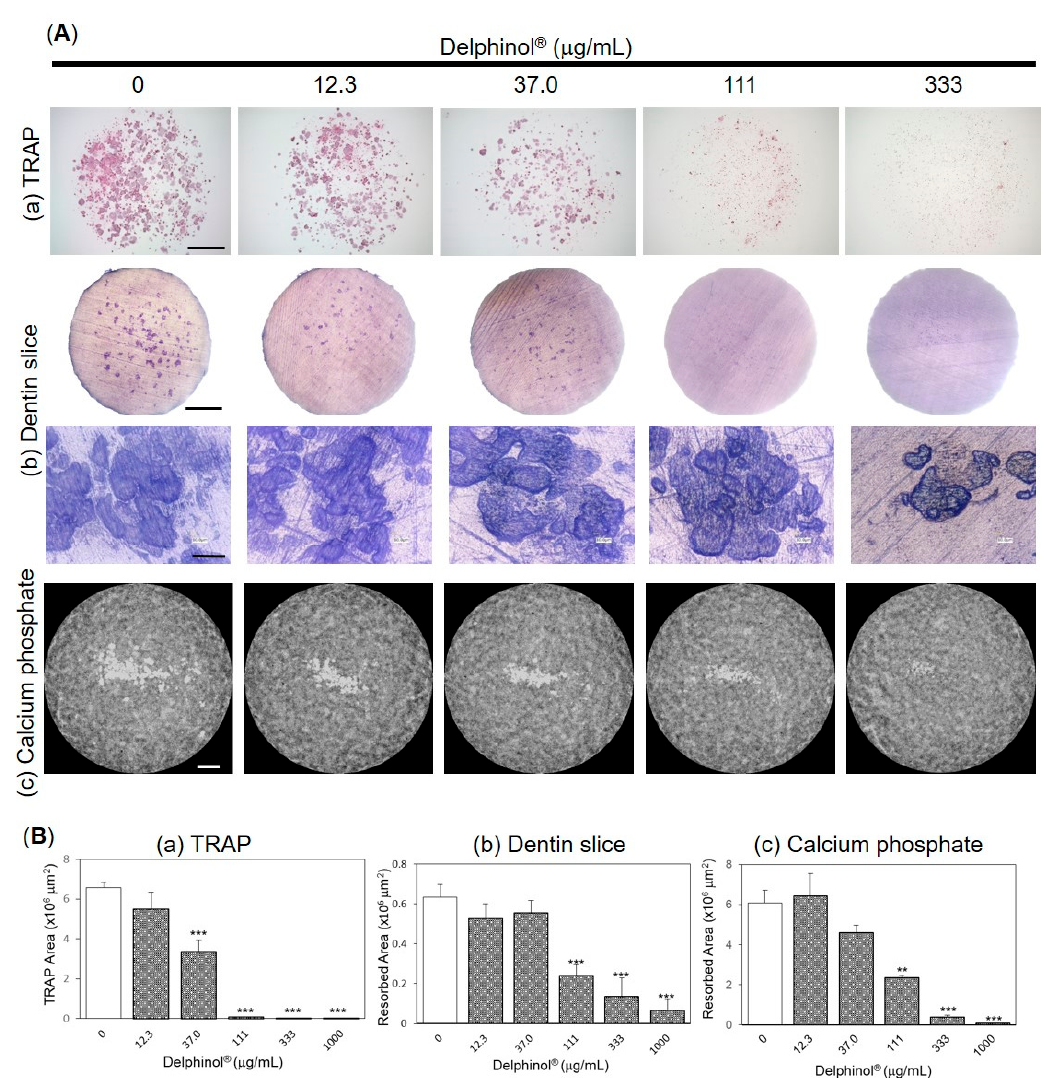
Figure 4. Effects of Delphinol ® on pit formation by mature OC. ( A ) Representative photographs of ( a ) TRAP staining, ( b ) resorption pit on dentine slices, and ( c ) resorption of calcium phosphate in OC cultures. ( B ) Anti-resorption activity of MBE was evaluated by measuring the area per well. Values are expressed as mean ± SD ( n = 3–4). ** p < 0.01, *** p < 0.001. Scale bars are 2 mm except for the lower panel of Figure 4Ab (20 μ m).